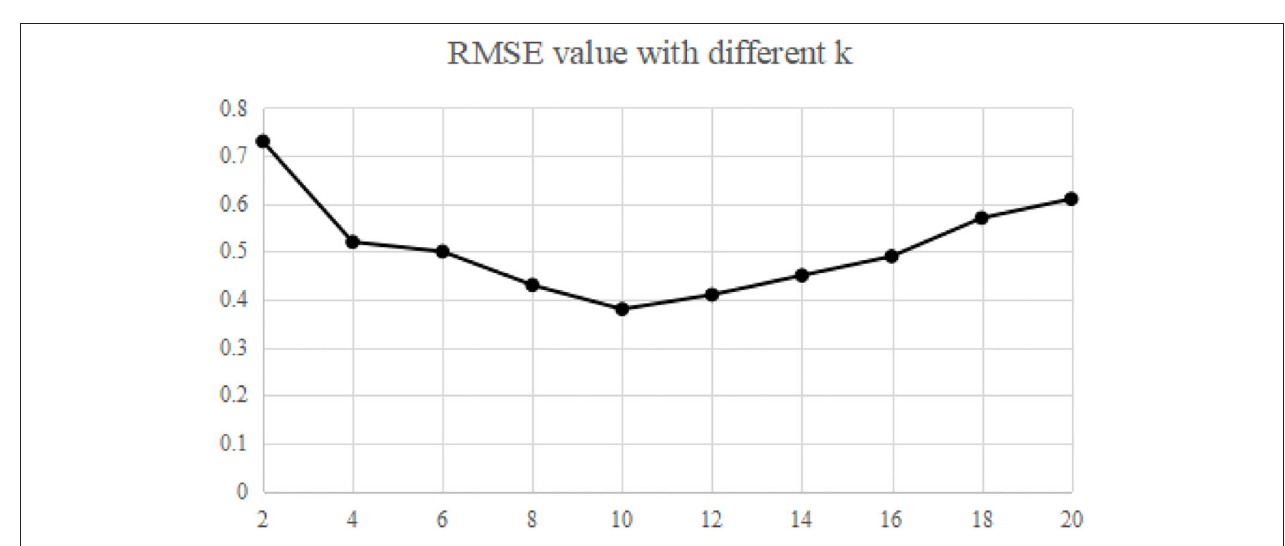
FIGURE 2 | Impact of k on RMSE (MovieLens).